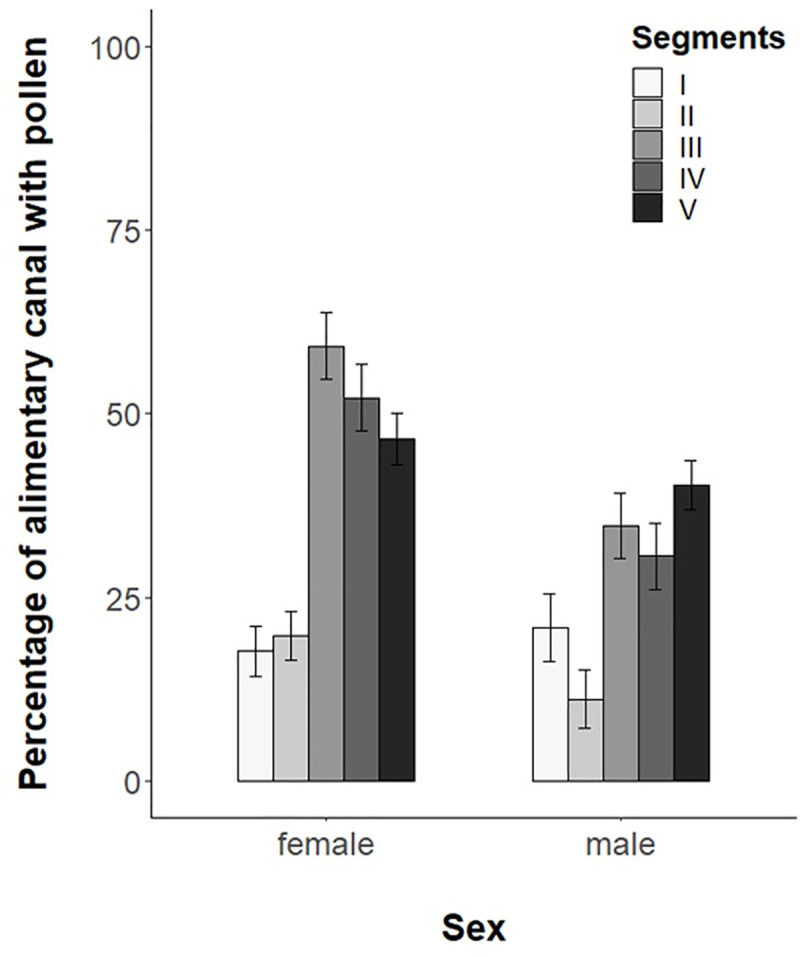
Estimated percentage of alimentary canal containing pollen (mean ± SE) in each segment (I–head; II–thorax; III–initial abdomen; IV–medium abdomen and V–final abdomen) by sex.